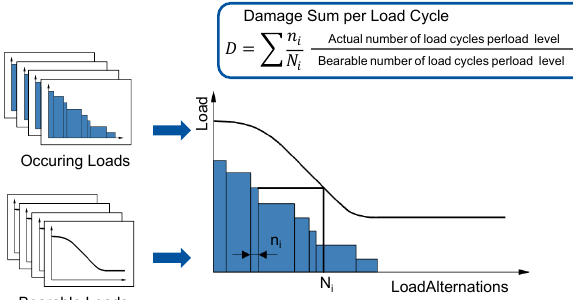
Figure 5: Schematic describing Palmgren-Miner dam- age accumulation theory (Miner,